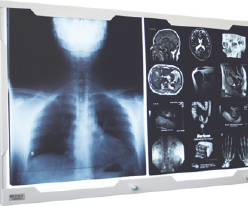
Fig. 1: A negatoscope used for viewing X-ray